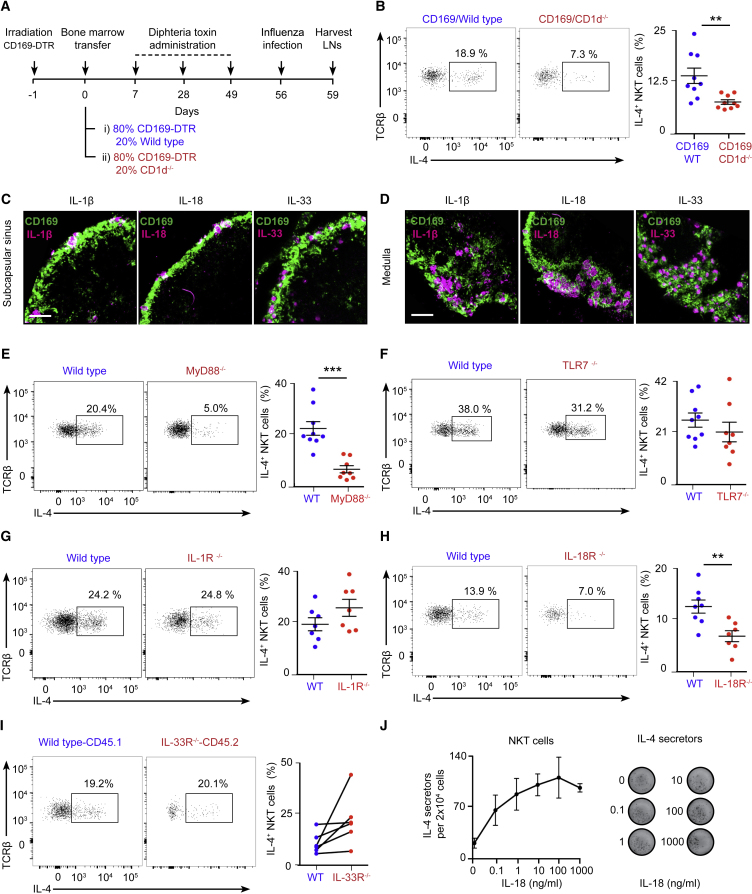
Resident Macrophages Promote Early NKT Cell IL-4 Production through CD1d and IL-18(A) Experimental scheme showing the strategy for the generation of chimeras lacking CD1d specifically on CD169+ macrophages.(B) Flow cytometry analysis of IL-4 production by NKT cells from mice subjected to the experimental scheme show in (A): wild-type chimeras (blue dots) and CD1d−/− chimeras (red dots).(C and D) Confocal microscopy analysis on day 2 of influenza infection showing (C) SCS and (D) medullar areas. Sections were stained with antibodies to CD169 (green) and IL-1β/IL-18/IL-33 (magenta). Scale bars, 60 μm.(E–I) Flow cytometry analysis of wild-type and (E) MyD88−/−, (F) TLR7−/−, (G) IL-1R−/−, and (H) IL-18R−/− mice or (I) IL-33R−/− chimeric mice on day 3 of influenza infection. Charts show IL-4+ NKT cells in wild-type (blue dots) or mutant (red dots) populations.(J) ELISPOT analysis of IL-4 production by sorted NKT cells incubated ex vivo with IL-18.Each dot represents one mouse. Data show mean ± SEM and are representative of 3 independent experiments. Statistical analysis: two-tailed Student’s t test, ∗∗p < 0.01, ∗∗∗p < 0.001.